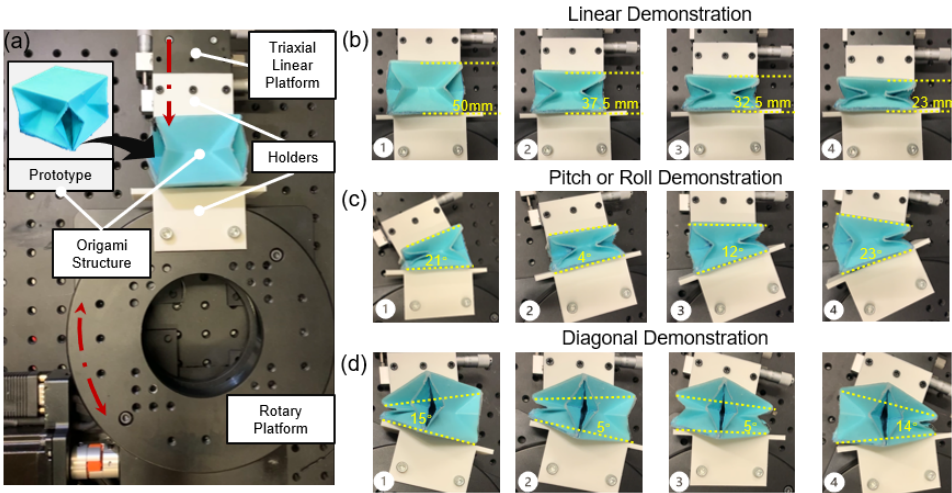
Figure 7. ( a ) Adaptation test setup. The experiment setup for the origami structure’s adaptation test. ( b ) The origami structure’s linear demonstration results. ( c ) The origami structure’s pitch or roll demonstration results. ( d ) The origami structure’s diagonal demonstration